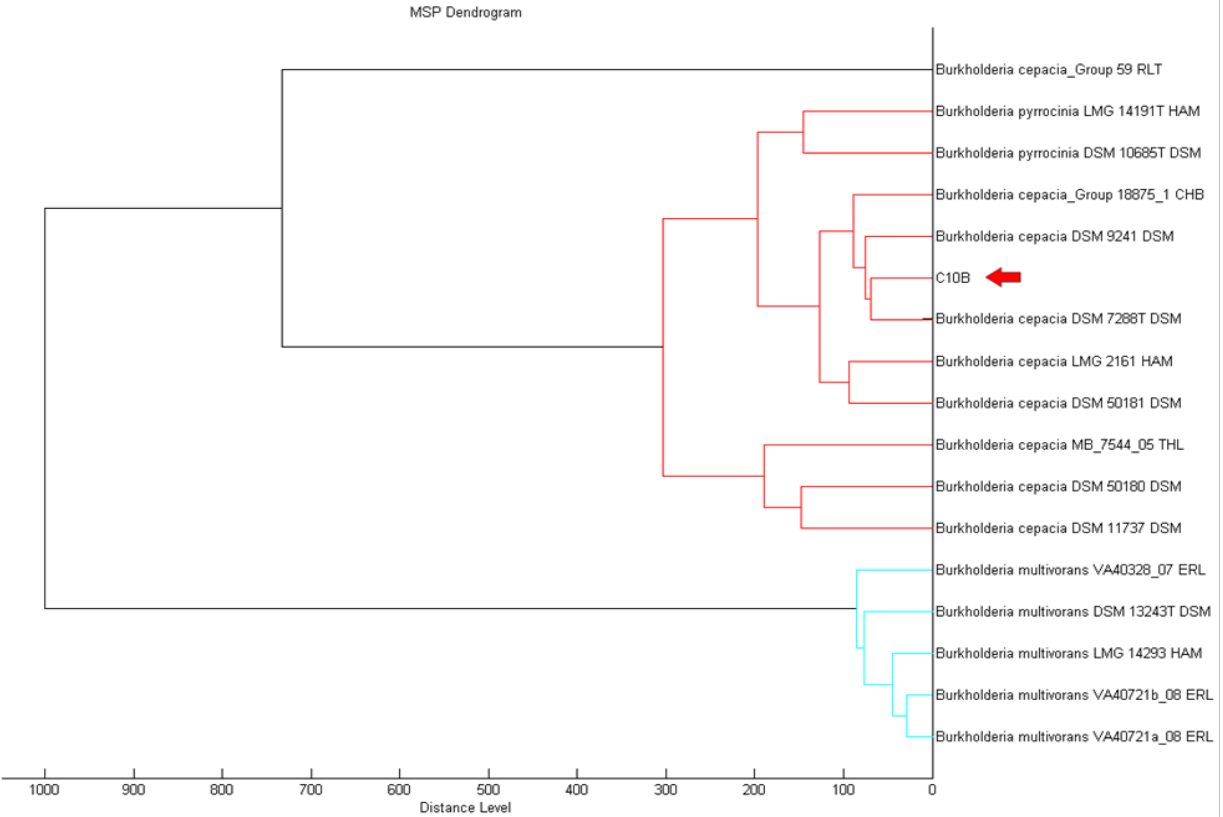
Figure 2. Score-orientated dendrogram that shows the classification of strain C10B. Bacterial strain C10B was clustered hierarchically as Burkholderia cepacia (red arrow) based on the protein mass spectra